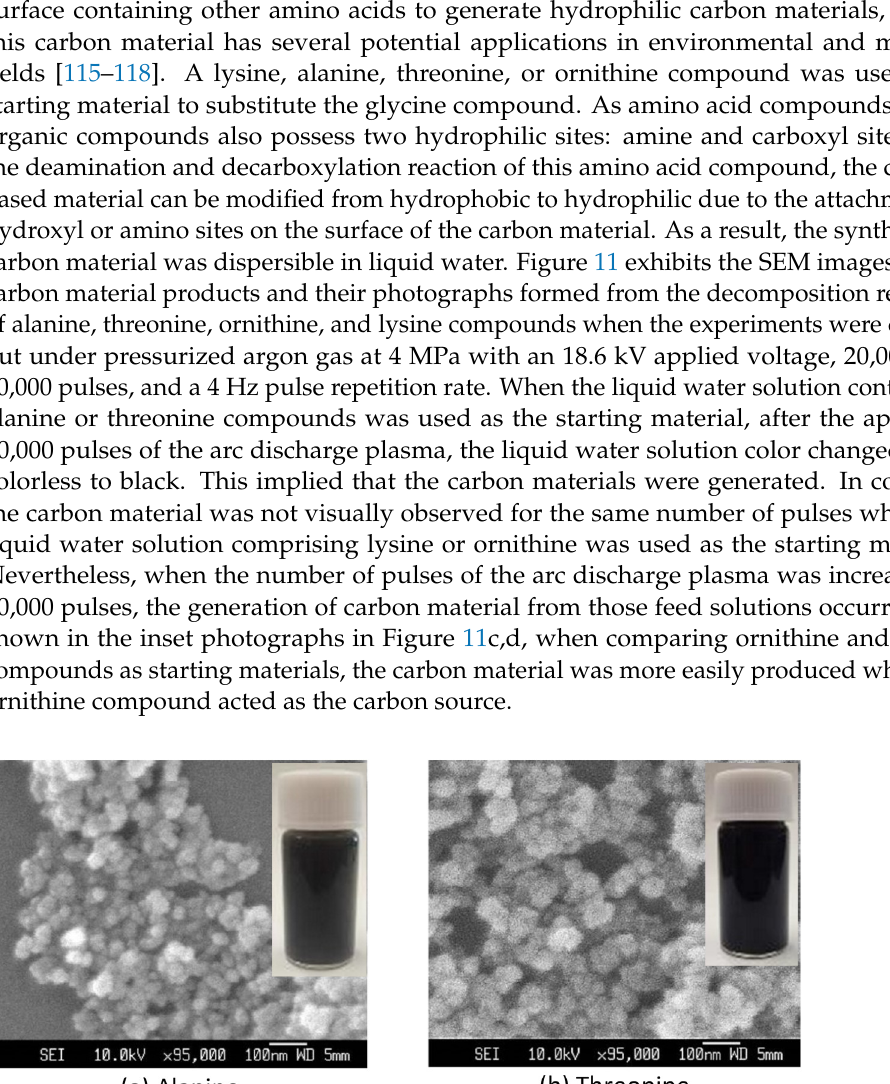
Figure 11. SEM images of the carbon material products formed from various amino acid compounds, with their photographs in the insets [41].